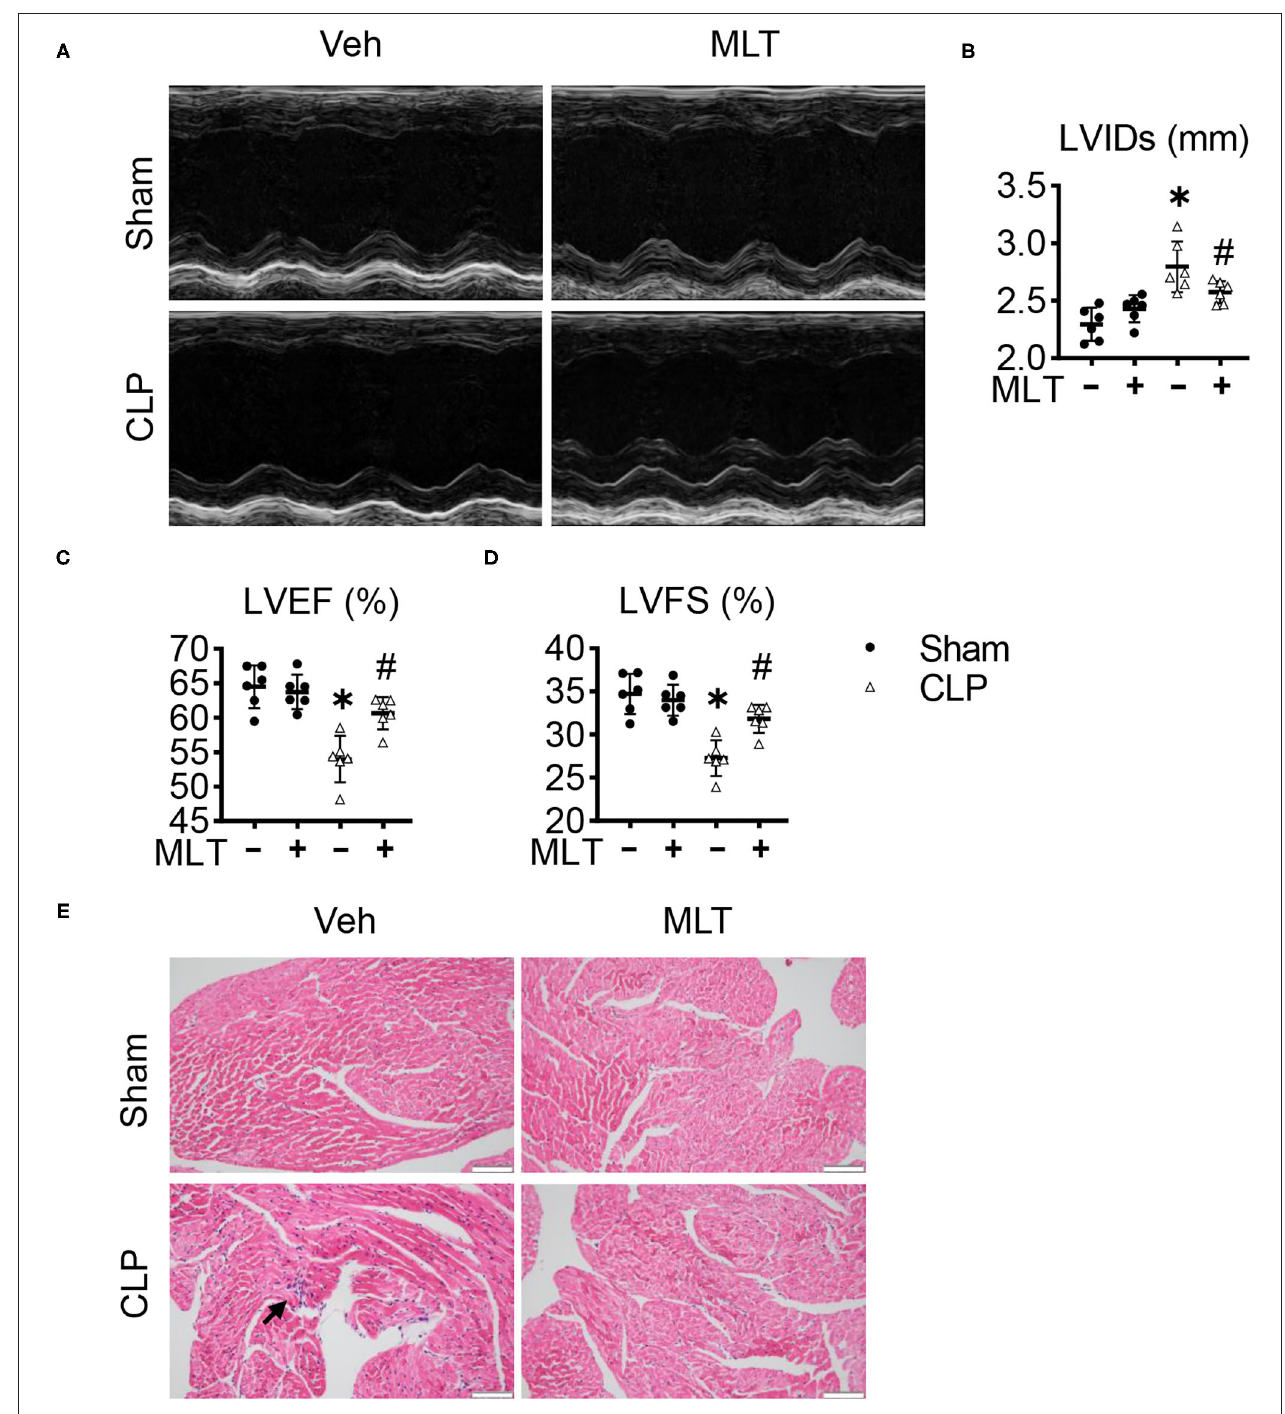
FIGURE 1 | Melatonin alleviates cardiac dysfunction in sepsis-induced myocarditis. Eight-week old mice were treated with melatonin (MLT) (25 µ g/ml) dissolved in drinking water for 14 days. (A) Representative echocardiogram of the cardiac function of mice (M-mode) for each condition. (B–D) Quantification of the left ventricular end-systolic diameter (LVIDs, mm), left ventricular ejection fraction (LVEF, %), and left ventricular fractional shortening (LVFS, %). (E) Representative images of the HE staining of the heart tissues (scale bar = 100 µ m), the black arrow indicates the inflammatory infiltration area. Values are presented as means ± SD, *vs. sham, p < 0.05; # vs. CLP, p <